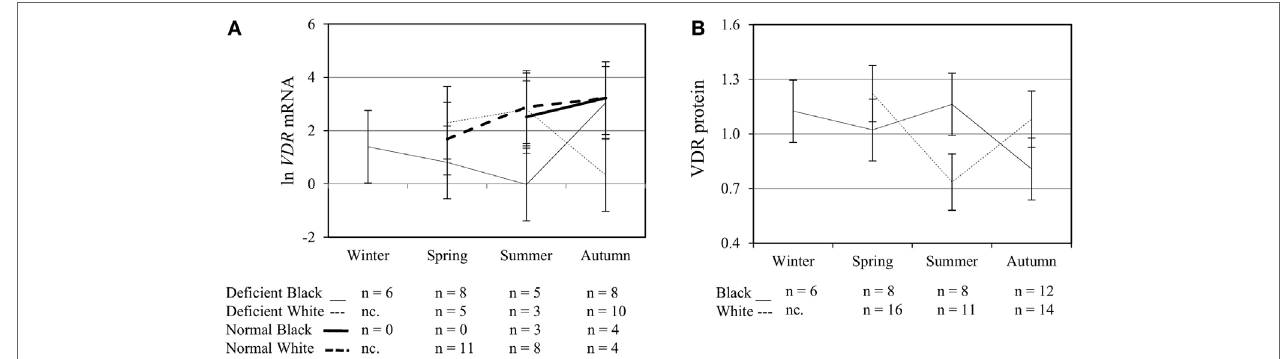
FigUre 4 | Interaction between season, race, and 25(OH)D 3 status influence vitamin D receptor ( VDR ) mRNA and protein level. The line graphs show the interaction effects for VDR mRNA (a) and protein (B) level, quantified by RT-qPCR and flow cytometry, in monocytes/macrophages from healthy Black ( n = 34) and White ( n = 41) South Africans. Season, race, and 25(OH)D 3 status interacted significantly to influence VDR mRNA ( P < 0.001), while season and race showed interaction effects on VDR protein ( P < 0.001). Error bars show the least significant difference at P < 0.050. nc. = not